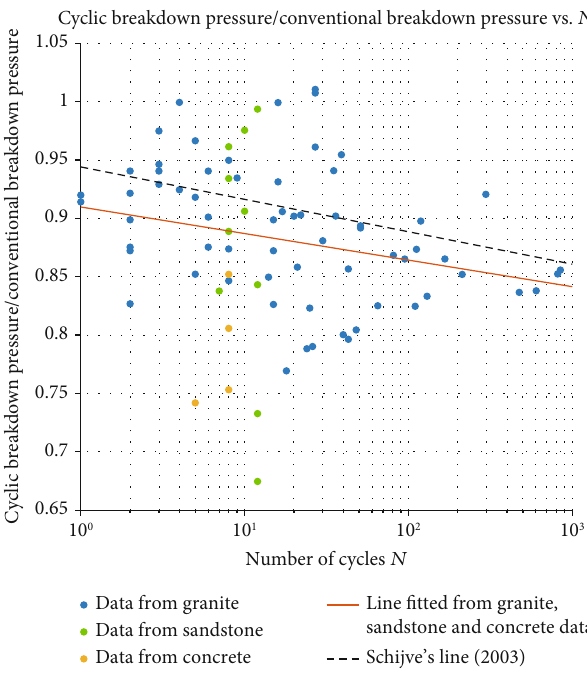
Figure 9: Normalized breakdown pressure (cyclic breakdown pressure/conventional breakdown pressure) versus the number of cycles N .